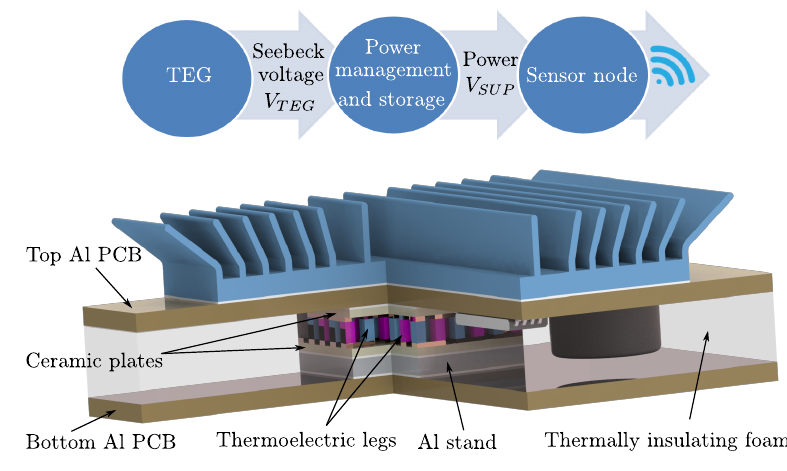
Figure 1. Block diagram and cross-sectional view of the thermoelectric energy harvesting WSN